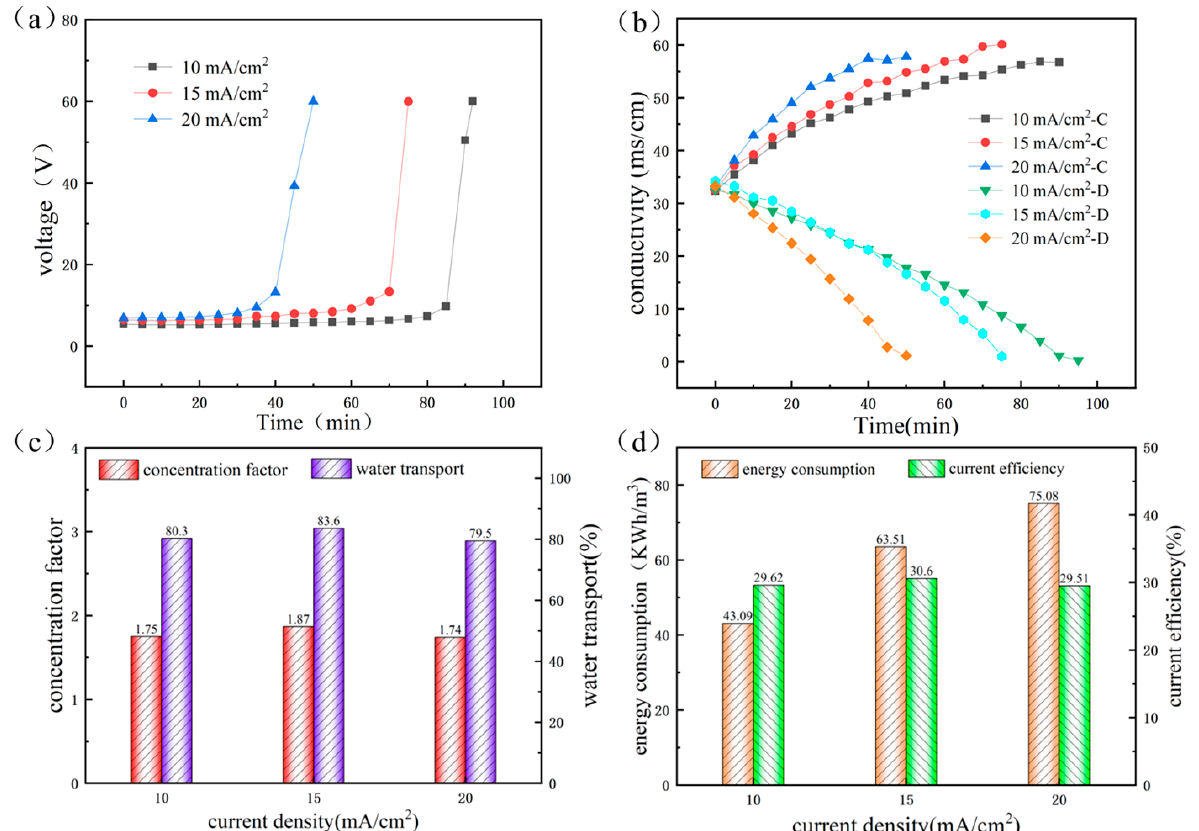
Figure 4. E ff ect of current density in second-stage ED process: ( a ) voltage drop, ( b ) desalination rate in dilute and concentrate compartment, ( c ) concentration factor and water transport, and ( d ) energy consumption and current e ffi ciency.